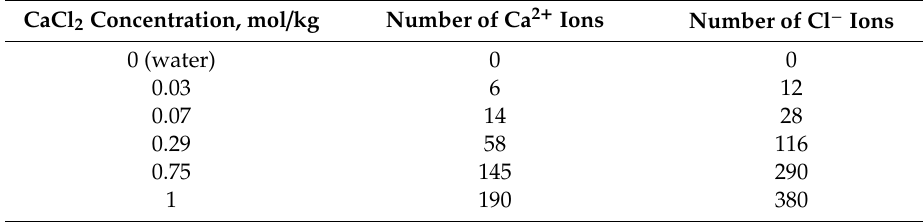
Table 1. The numbers of ions used in the simulated